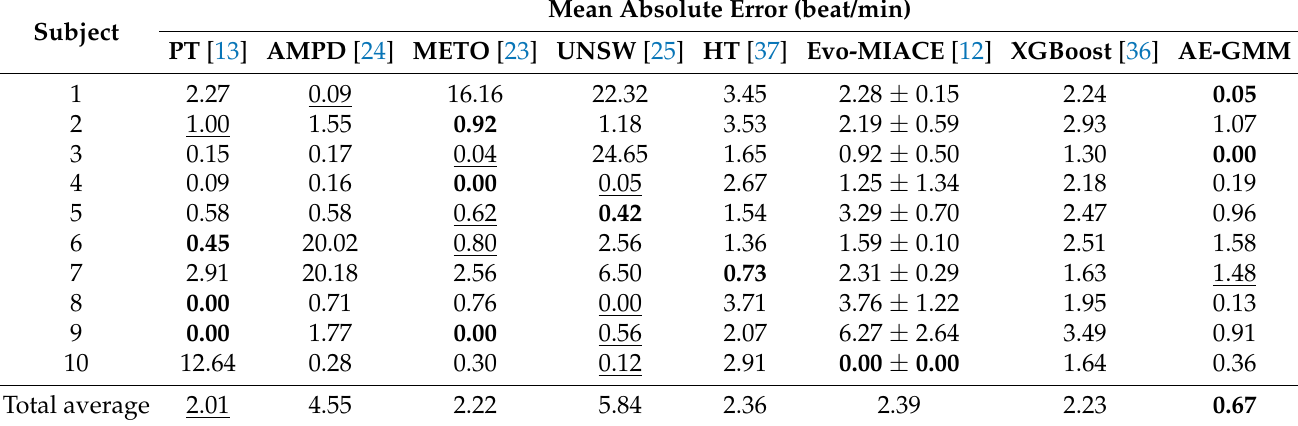
Table 4. Performance of AG-GMM and comparisons across the 10 subjects, bold for the best, underline for the second best, standard deviations smaller than 0.01 are denoted as 0.00.